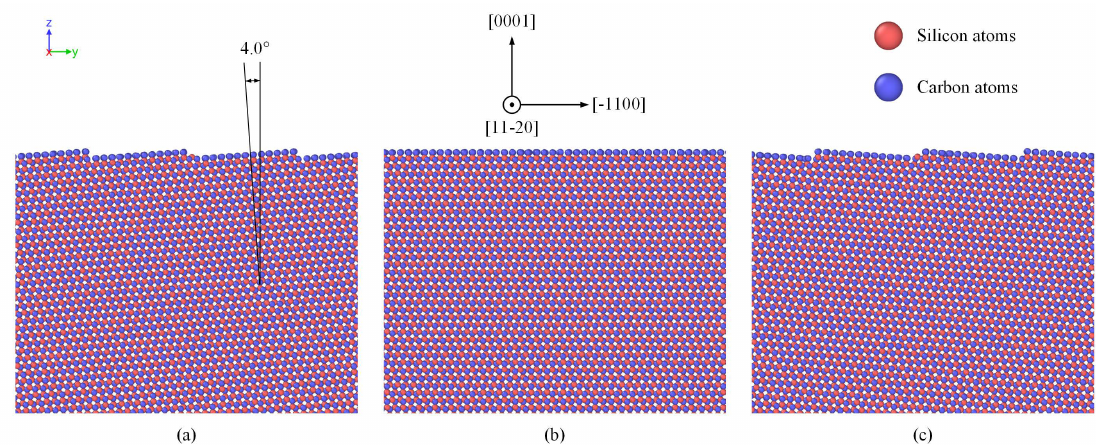
Figure 1. Nanocutting molecular-dynamics (MD) model of off-axis 4H-SiC.